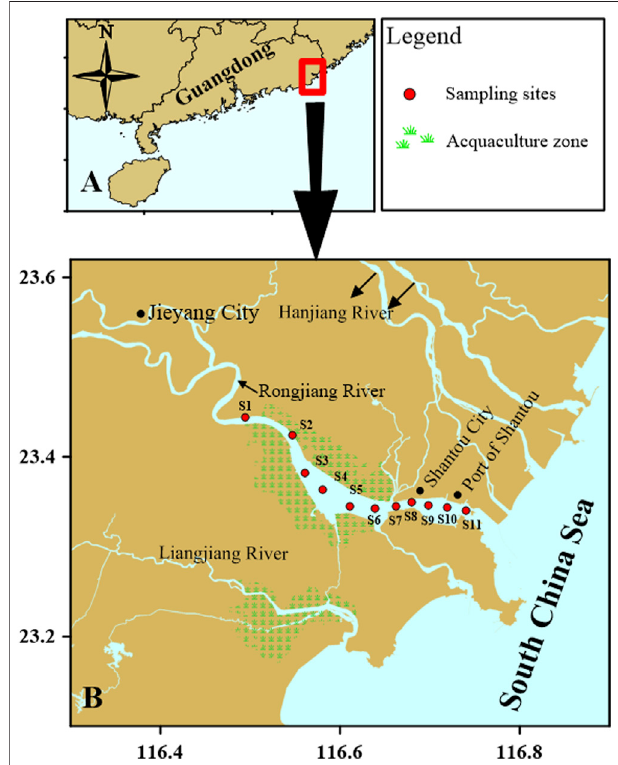
FIGURE 1 | Local geography, sampling stations (red spots), and aquaculture areas (green symbols), Rongjiang River, South China Sea.